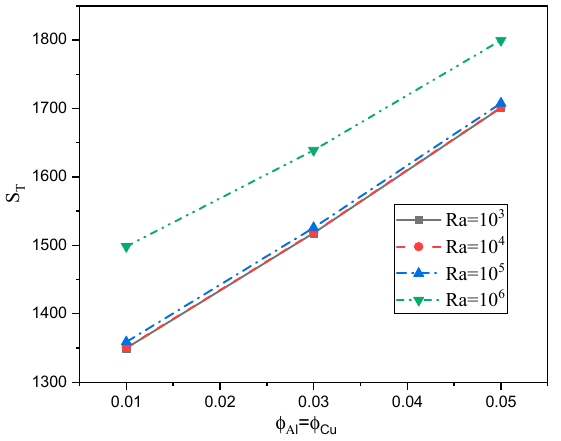
Figure 10. Profiles of the S T of the nanofluid phase in the entire domain for the variation of the Rayleigh number and nanoparticle volume fraction φ Al = φ Cu at Ha = 15, H = 0.1, γ = π /6, Φ = π . 3